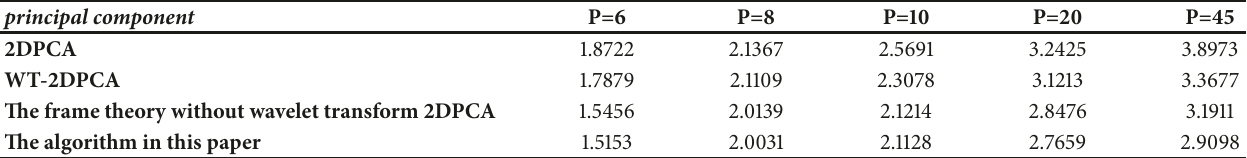
Table 2: The comparison of the recognition time between the 2DPCA algorithm and this algorithm under different principal components in the ORL Library